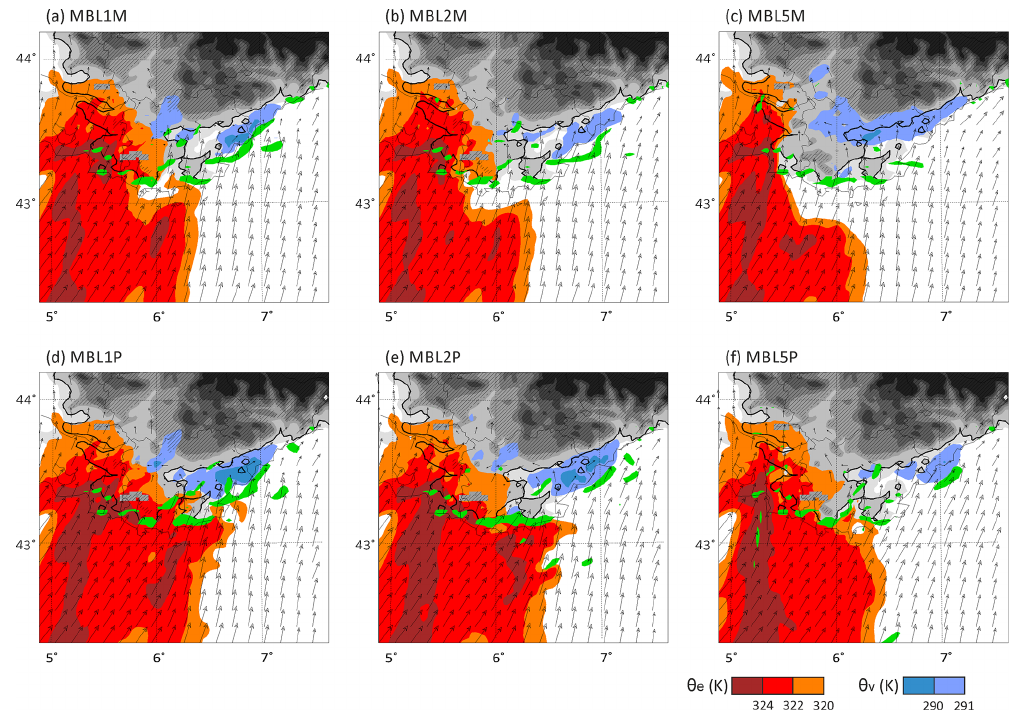
Figure 11. Equivalent potential temperature θ e at 925hPa (K, red areas), virtual potential temperature θ v at the first model level (K, blue areas below 292K), vertical motion at 500ma.s.l. (green areas above 0.5ms − 1 , arrow), and horizontal wind at 925hPa simulated by (a) MBL1M, (b) MBL2M, (c) MBL5M, (d) MBL1P, (e) MBL2P, and (f) MBL5P at 15:00UTC on 14 October